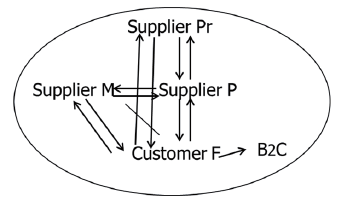
Fig. 4. – Customer F and its business network. Source: Authors.